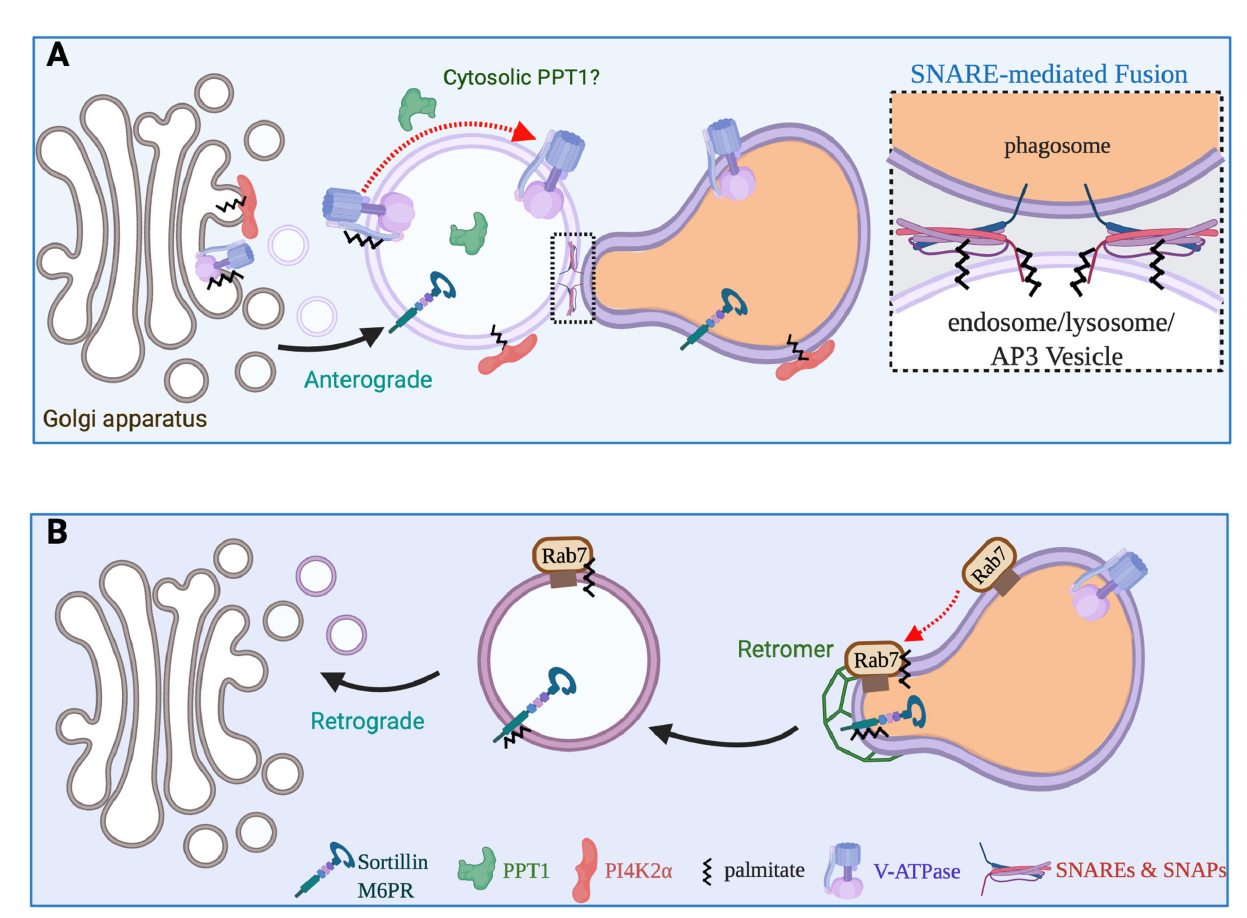
FIGURE 4 | Vesicular transport pathways required for phagosome maturation. (A) The maturing phagosome undergoes numerous SNARE-mediated fusion events during the course of its maturation. SNAP23 and SNAP25 are S -acylated, while a subset of SNARE proteins also require acylation for proper function and stability. Newly synthesized v-ATPase transits from the Golgi to late endosomes/lysosomes or directly to maturing phagosomes. The clathrin adaptor complex 3 aids in the sorting and delivery of a variety of proteins including the PI4KII a and cargo receptors such as sortillin to the (phago)lysosome. S -acylation of the PI4KII a and v- ATPase is critical to deliver these enzymes to (phago)lyosomes. (B) Cargo receptors M6PR and sortillin must constantly traf fi c back and forth between the Golgi apparatus and (phago)lysosomes to ensure that pro-hydrolytic enzymes are properly delivered to the lumen of (phago)lysosomes. Both the cation independent M6PR and Sortillin can be S -acylated and modi fi cation aids in interactions with the retromer complex. Additionally, S -acylation of Rab7 also promotes its interactions with the retromer complex and the retrieval cargo